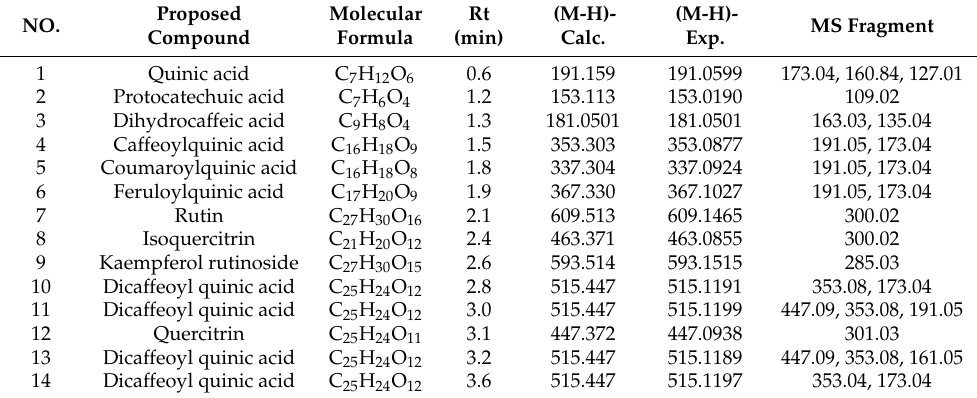
Table 3. Identified phenolic components in Calystegia soldenella ethyl acetate fraction using UPLC Q-TOF